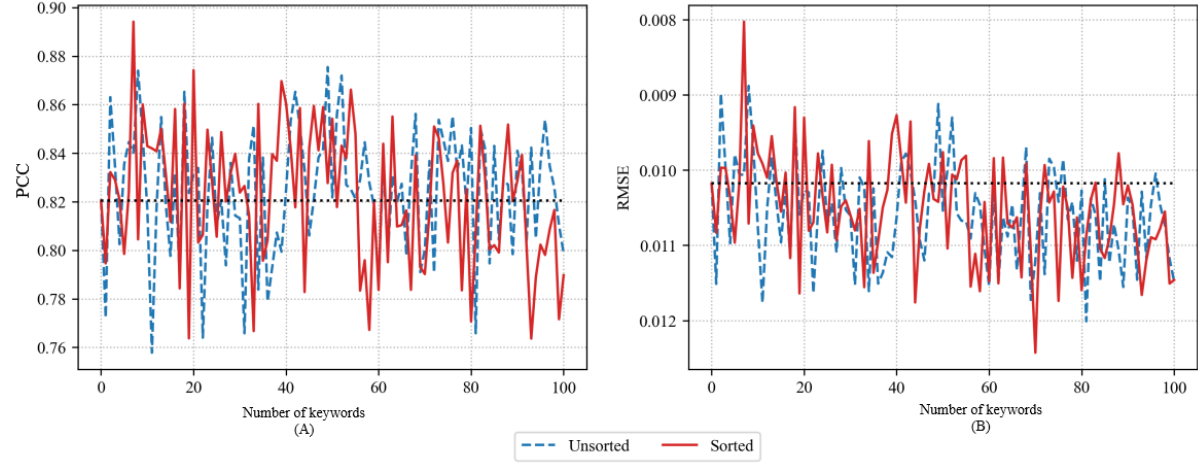
Figure 3. Pearson correlation coefficient (PCC) (A) and root-mean-square error (RMSE) (B) of long short-term memory models using Word2Vec